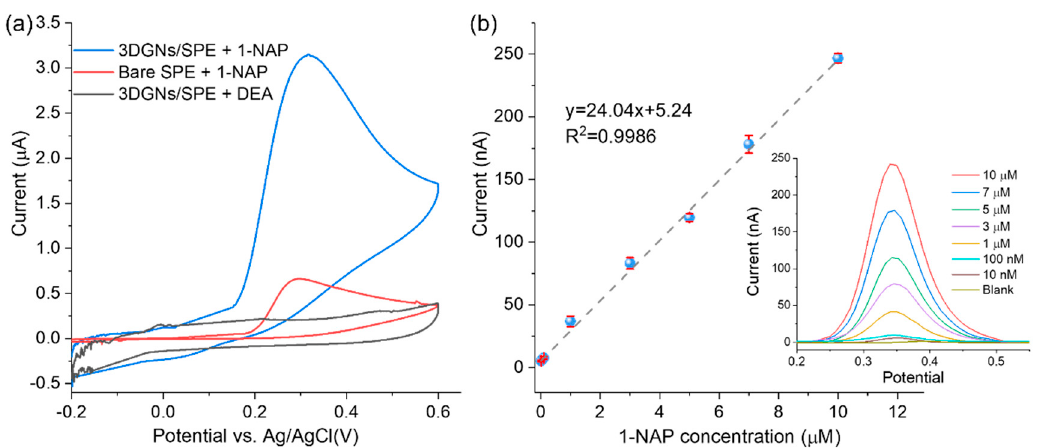
Figure 3. ( a ) CV characterization of the electrochemical oxidation of 1-NAP by 3DGNs/SPE compared with bare SPE; ( b ) calibration curve of the current peaks for 1-NAP oxidation at 0.35 V. Error bars represent the RSD of triple measurements. The inset shows DPV curves of the enzymatic product 1-NAP in DEA buffer with the concentration range from 0.01 to 10 μ M obtained by 3DGNs/SPE.